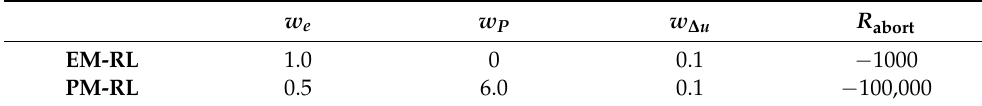
Table 3. Reward function parametrizations: the error-minimizing reward parametrization (EM-RL) and power-minimizing reward parametrization (PM-RL). w